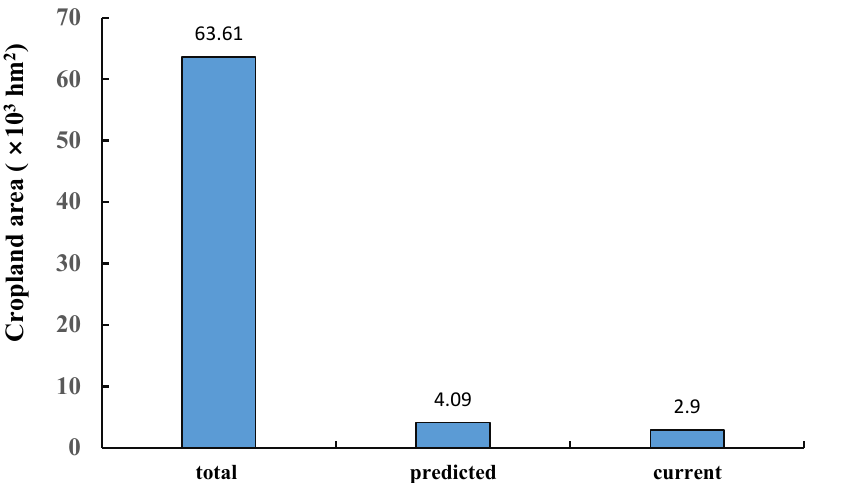
Figure 5. The total cropland, predicted fallow cropland, and current cropland in Quzhou County in 2018.